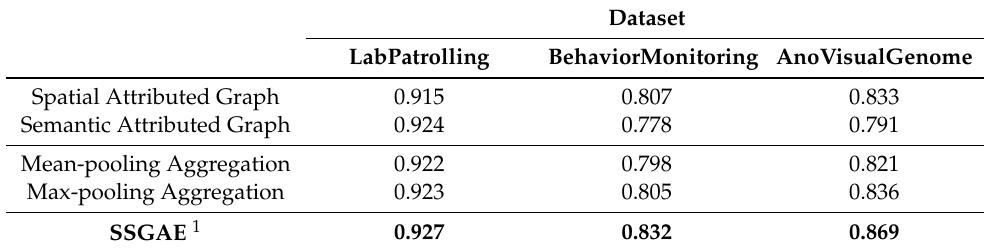
Table 3. Effectiveness of different components in our method.